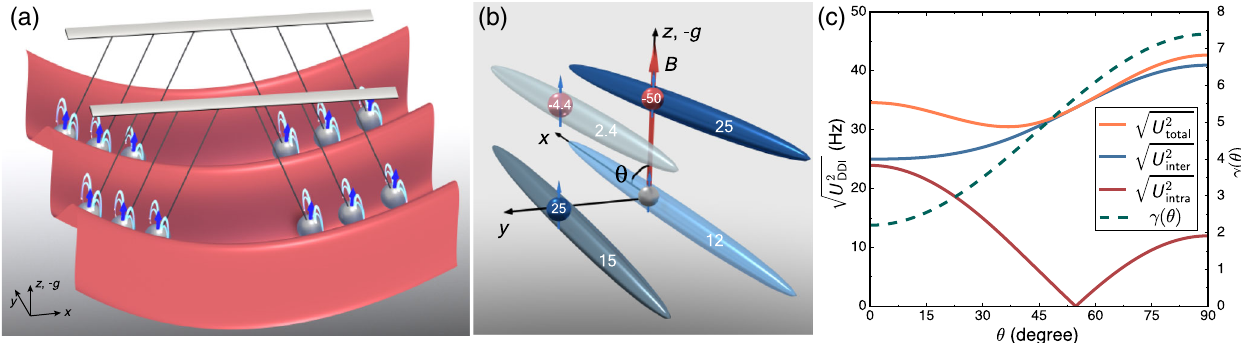
FIG. 1. Dipolar Newton ’ s cradle setup. (a) Two of the 1D tubes of atoms in a dipolar quantum Newton ’ s cradle. Application of an optical phase grating (not shown) kicks atoms along the tubes, and the weak harmonic confinement induces periodic collisions. The highly magnetic dysprosium atoms (silver spheres) are trapped in a 2D optical lattice (red) defining the tubes. (b) DDI strength between the central atom and atoms in neighboring tubes in one quadrant of the square lattice when θ ¼ 90 °, where θ is the angle between the B-field in the xz -plane and the axis of the 1D tubes along ˆ x . The patterns of strengths in the other three quadrants are the same by symmetry. The DDI strength is tunable via changing θ . Numbers labeled on the atoms and the tubes are the pairwise DDI strength and integrated DDI along the tubes, respectively, in Hz. Blue indicates large positive strength, and red large negative strength. (c) Dependence of integrability-breaking dipolar interaction strength and γ on θ . Solid curves: Integrability-breaking contributions of the DDI energy U (added in quadrature and defined in Appendices A – C) versus θ . Shown are the total, total intertube, and total DDI integrability-breaking intratube DDI energies. While the intratube DDI is maximally repulsive (attractive) for θ ¼ 90 ° (0°), it vanishes among intratube atoms for θ ¼ 55 °. Integrability-breaking DDI contributions come not just from the intratube 1D DDI along ˆ x , but also from the 3D DDI between atoms in all neighboring tubes along ˆ y and ˆ z . This dilutes the tunablility of the DDI, reducing the contrast to a factor of approximately 1.5 between θ ¼ 0 ° and 90°. Dashed curve: Lieb-Liniger parameter γ ð θ Þ ; see Appendix D for